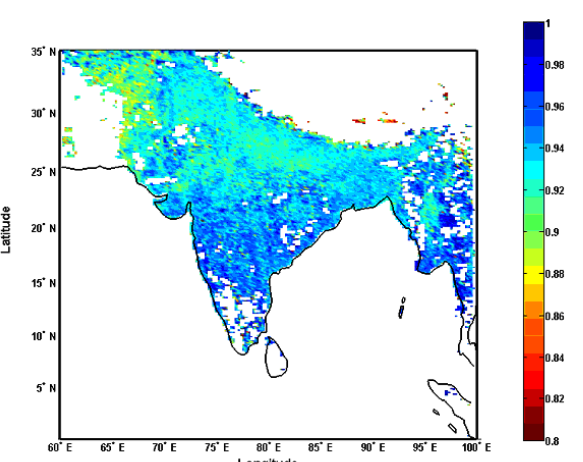
Fig. 4. Regional distribution of aerosol SSA.